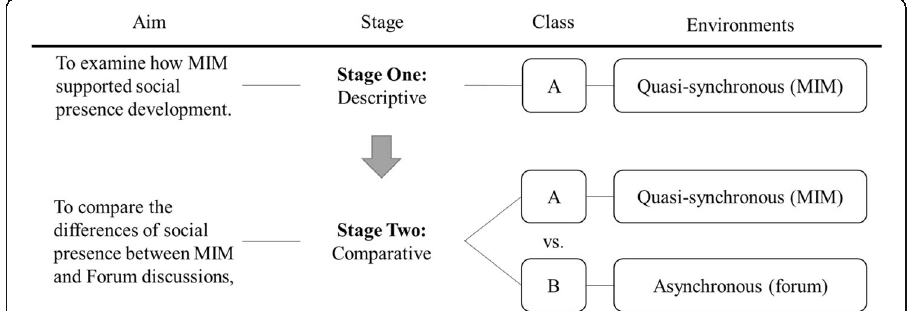
Fig. 1 Overview of the two-stage